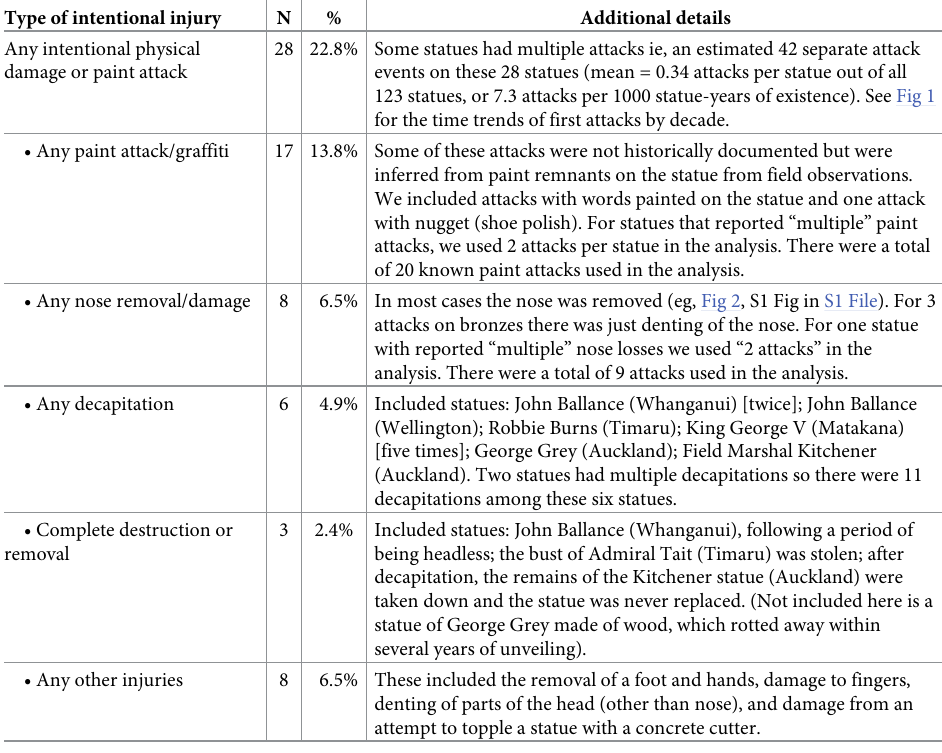
Table 2. Type of injuries from attacks on the statues of named figures in outdoor public settings in this national survey. Type of intentional